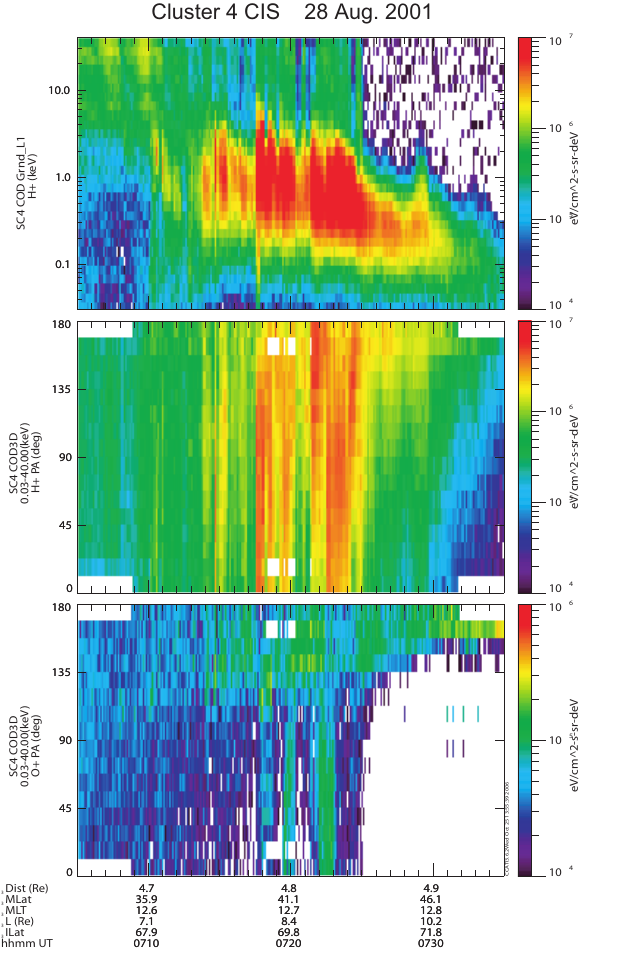
Fig. 7. A plot of the CIS data from C4. The top panel is an energy- vs-time spectrogram with H + energy flux color-coded. The middle and bottom panels display the pitch angle distribution for H + and O + , respectively.